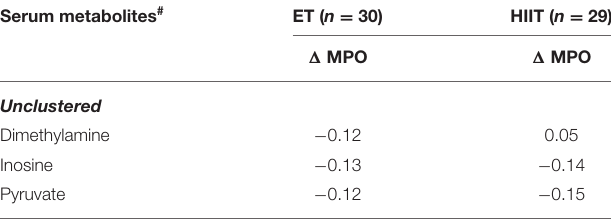
TABLE 2 | Pearson’s correlation coefficients (r) for the association between MPO gains and the pretraining to post–training changes in skeletal muscle metabolites’ concentration levels in the TIMES